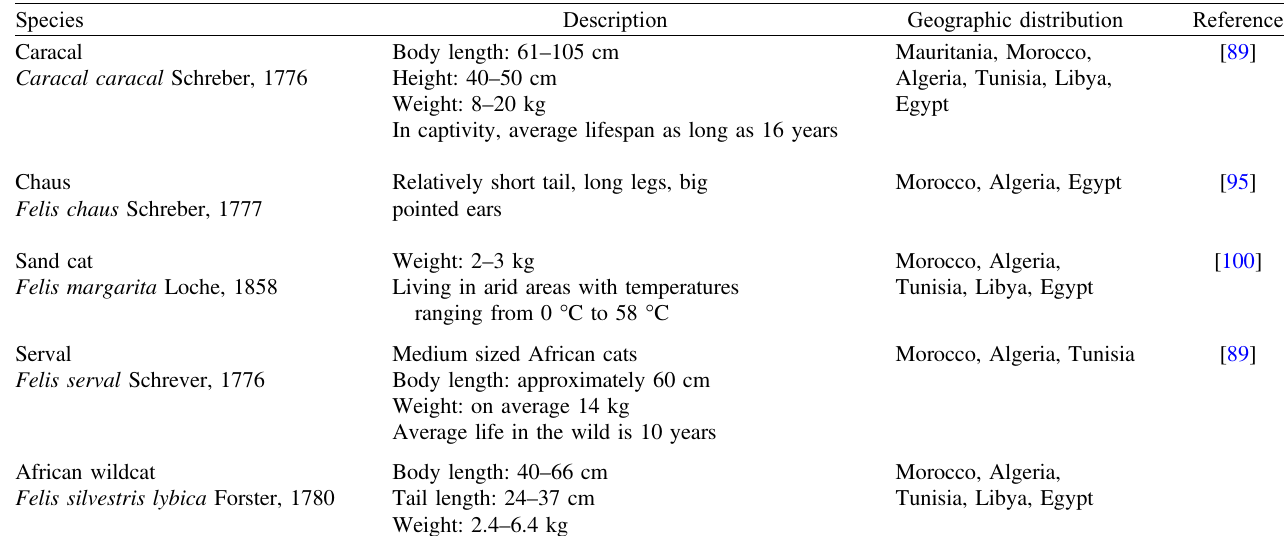
Table 3. Wild felid species present in North Africa.